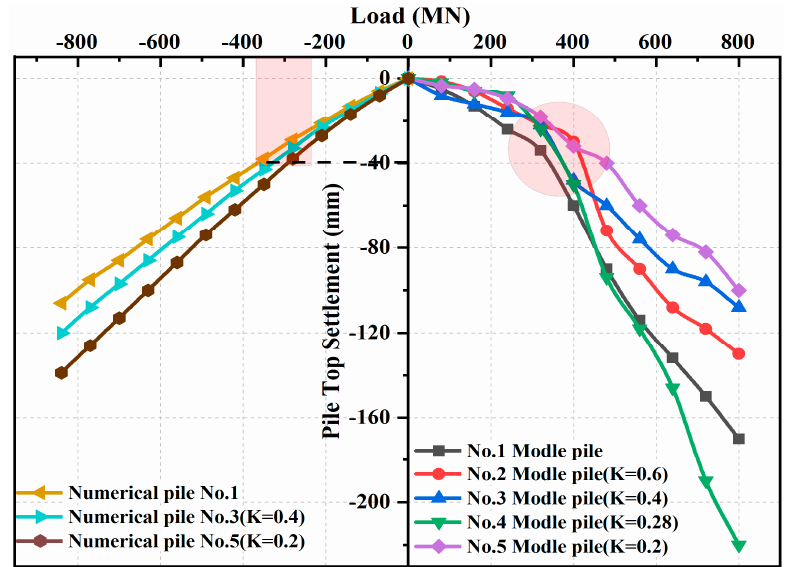
Figure 17. Comparison of pile-top settlements.